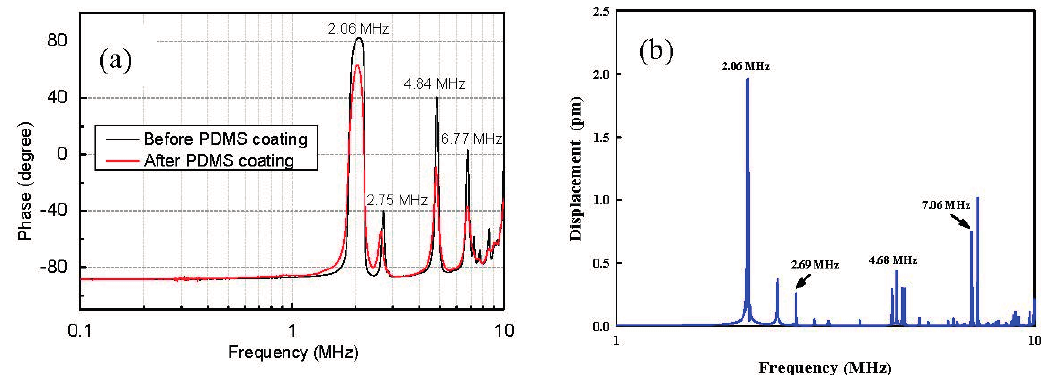
Figure 3. ( a ) Impedance spectrum of the PZT element in the frequency domain up to 10 MHz; and ( b ) the simulated average displacement across the surface of the PZT element using the finite element